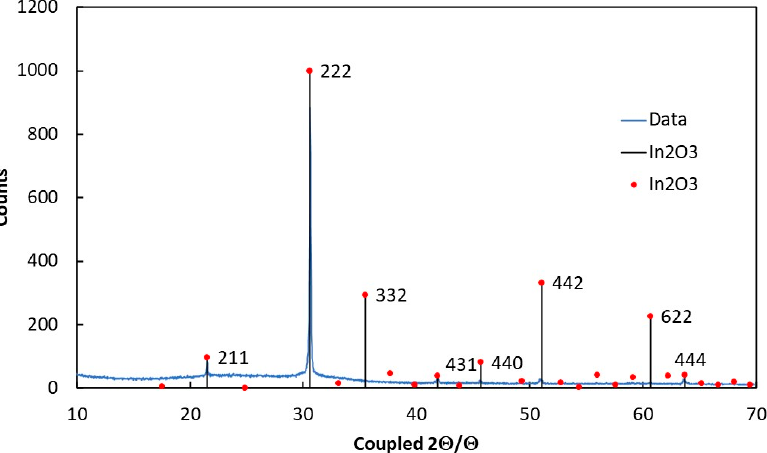
Figure 3. XRD spectrum of In 2 O 3 − x on a glass substrate: comparison with peaks in cubic centered form BCC c-In 2 O 3 (JCPDS card number 06-0416) .